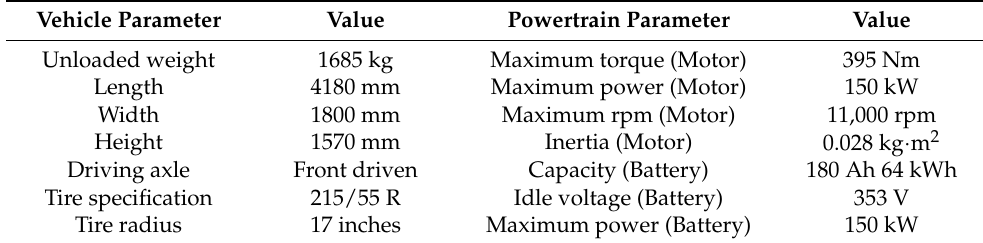
Table 4. Specification of the vehicle (Hyundai KONA).